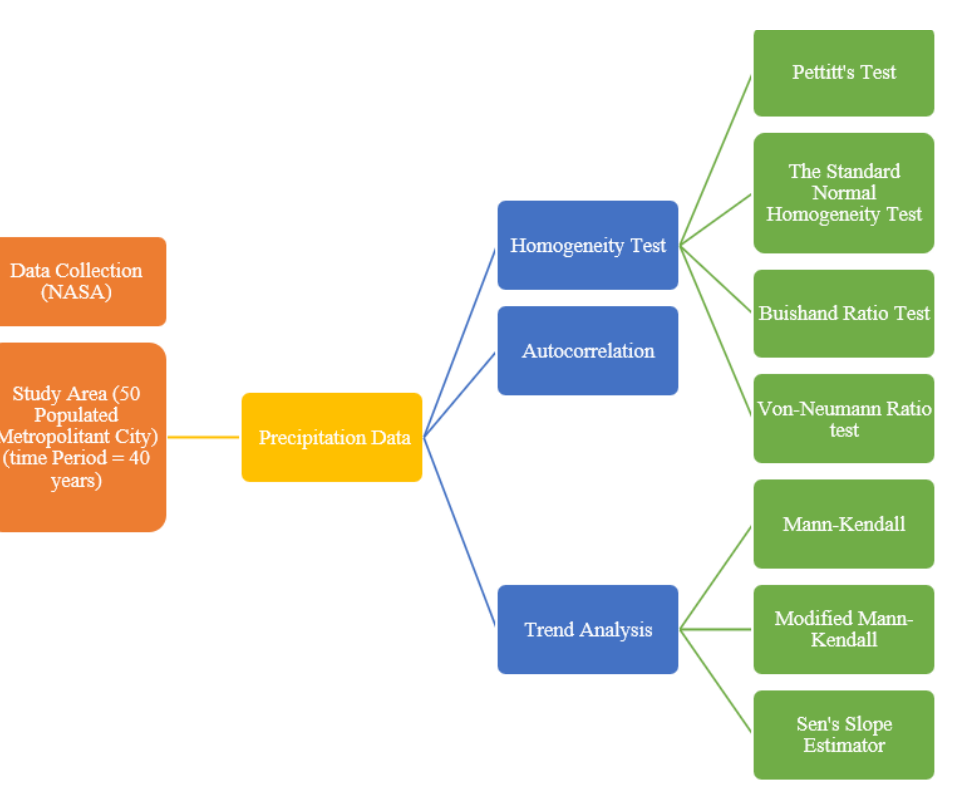
Figure 2. Flowchart of adopted methodology in the study.